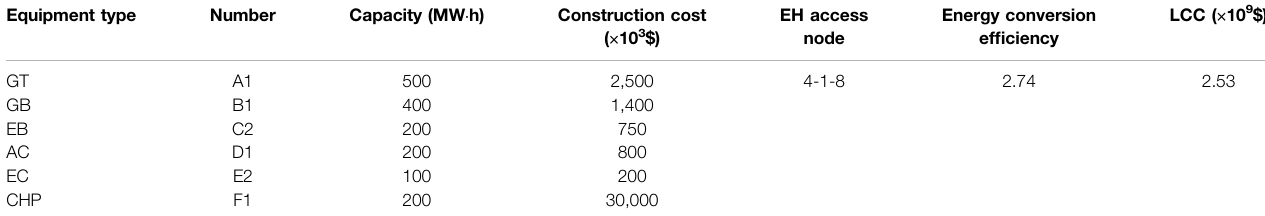
TABLE 3 | EH planning results under S2. Equipment type